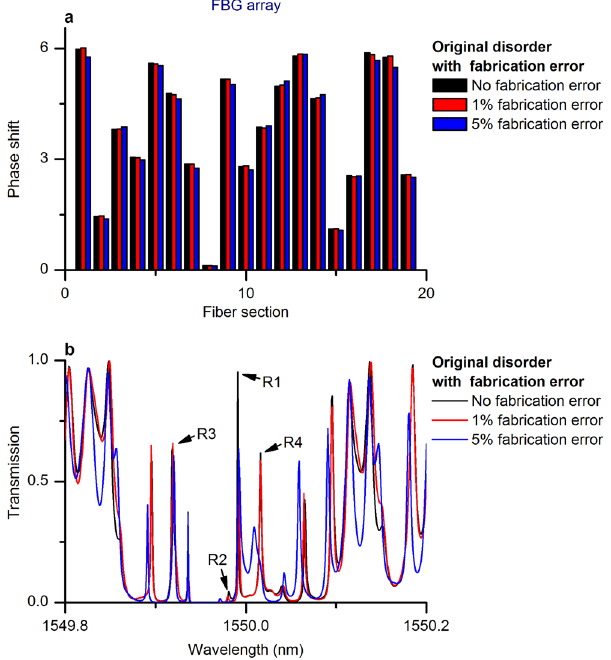
Figure 8. Influence of fabrication error on the FBG array with original disorder. ( a ) Fabrication error. ( b ) Error-induced resonance fluctuations and